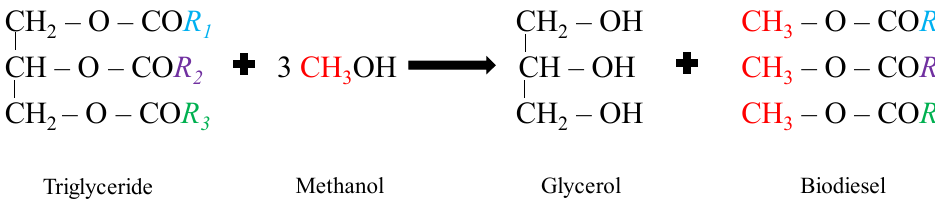
Figure 1. Reaction of biodiesel formation.